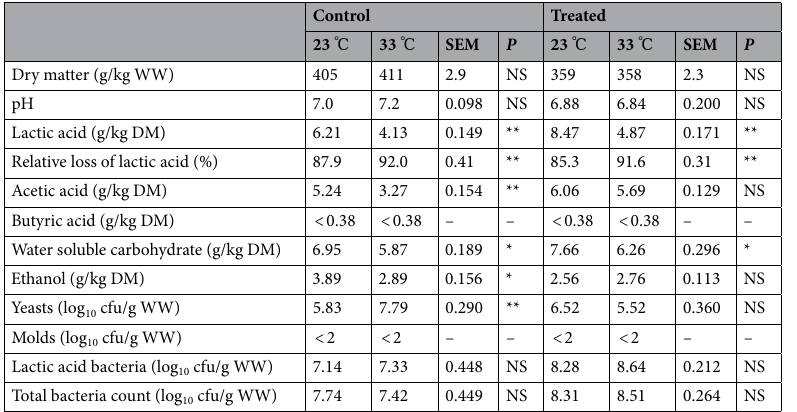
Table 2. Final ( i.e ., 168 h of aerobic incubation) chemical and microbial analyses of the two silages, not treated or treated with a biological additive. WW, wet weight; DM, dry matter; cfu, colony-forming units. *,